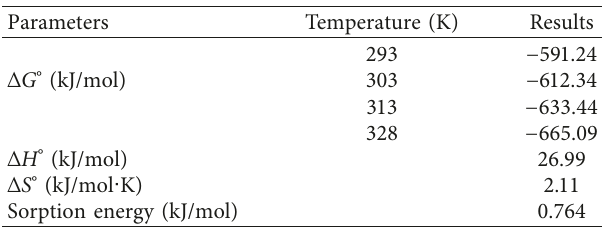
Table 4: Thermodynamic parameters for adsorption of